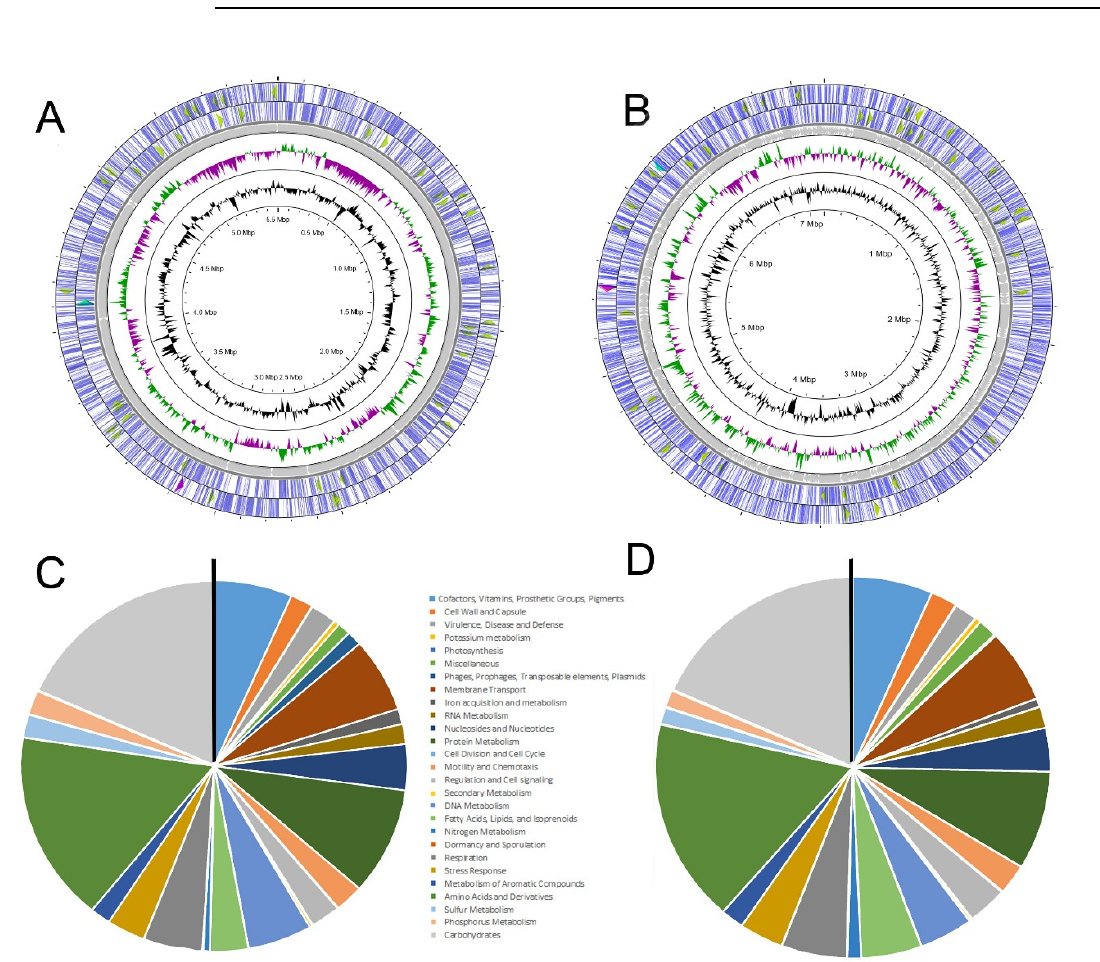
Figure 1. Genome circular representation and subsystems category distribution of annotated genes of the Phyllobacterium endophyticum PEPV15 T genome ( A , C ) and the Rhizobium laguerreae PEPV16 T ( B , D ). ( A , B ) From the outer to inner circles show coding sequences (CDSs; blue), rRNAs (violet), tmRNAs (turquoise), contigs (light grey), GC content (black), GC skew curves (+/ − ; green/purple). ( C , D ) Annotation of Phyllobacterium endophyticum PEPV15 T and Rhizobium laguerreae PEPV16 genomes via the RAST server, respectively. Subsystems are placed following the order of the legend, starting at the position of the black bar, from right to left. Table 3. Genome characteristics of 1, Phyllobacterium endophyticum PEPV15 T ; 2, Rhizobium laguerreae PEPV16.